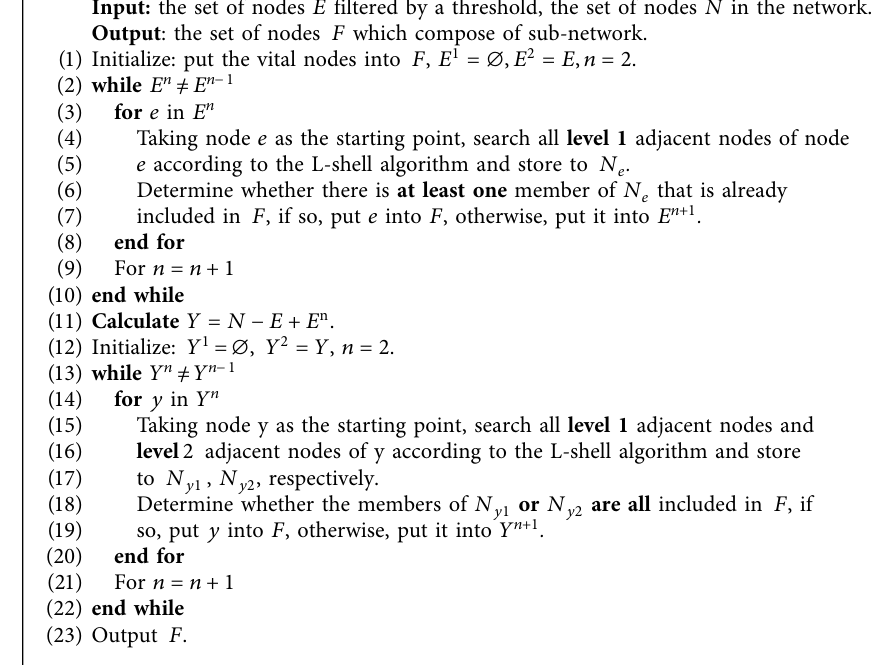
A LGORITHM 2: Modified L-shell algorithm.